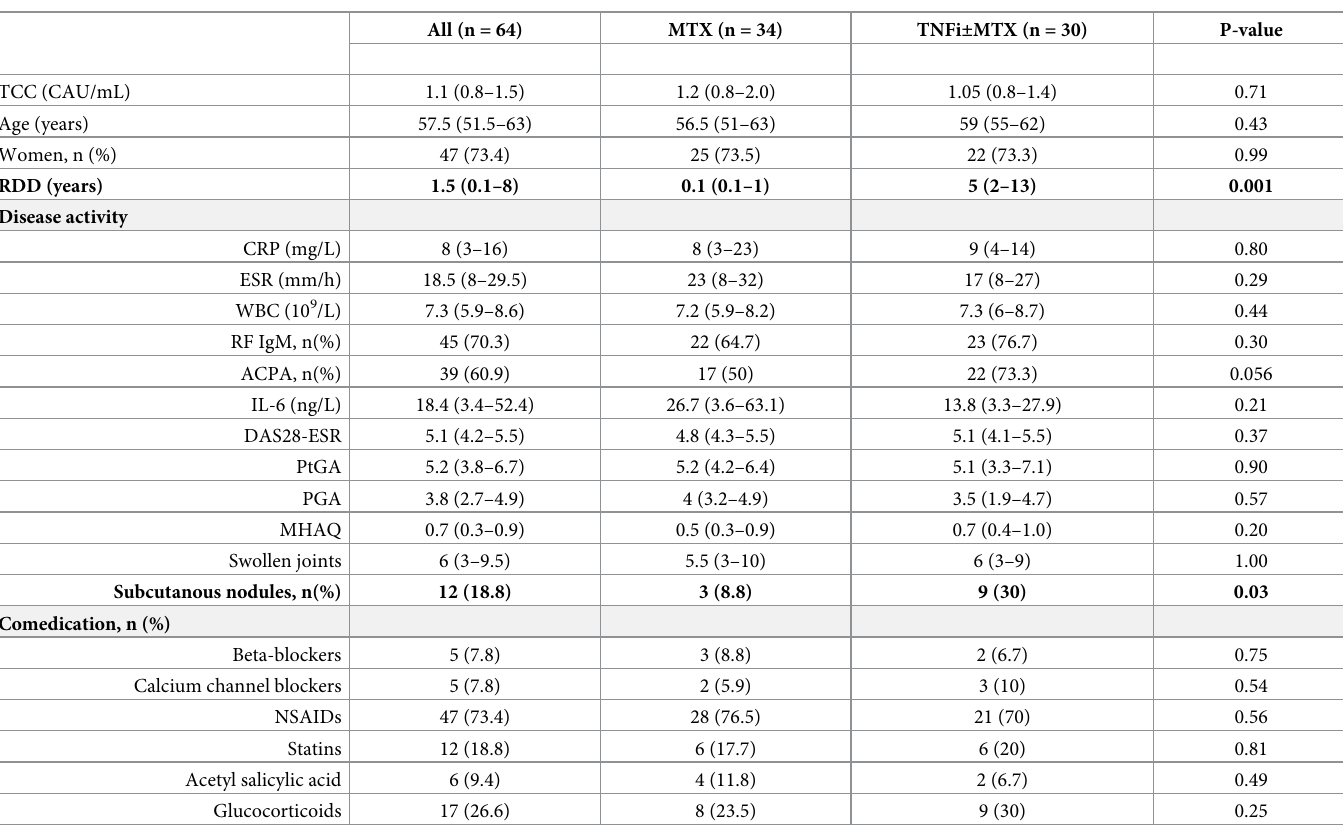
Table 1. Baseline clinical characteristics.